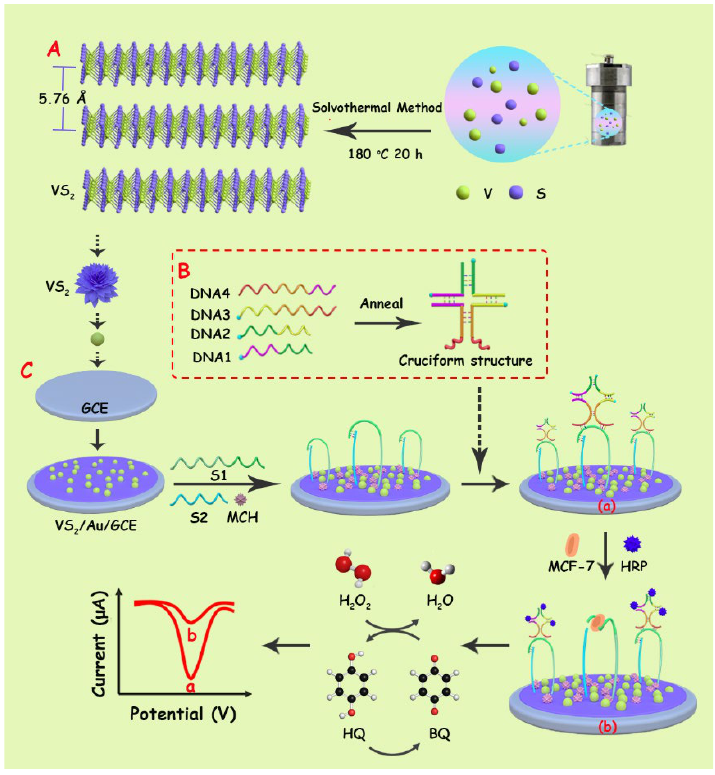
Scheme 1. Illustration of highly sensitive breast cancer cell sensor based on VS 2